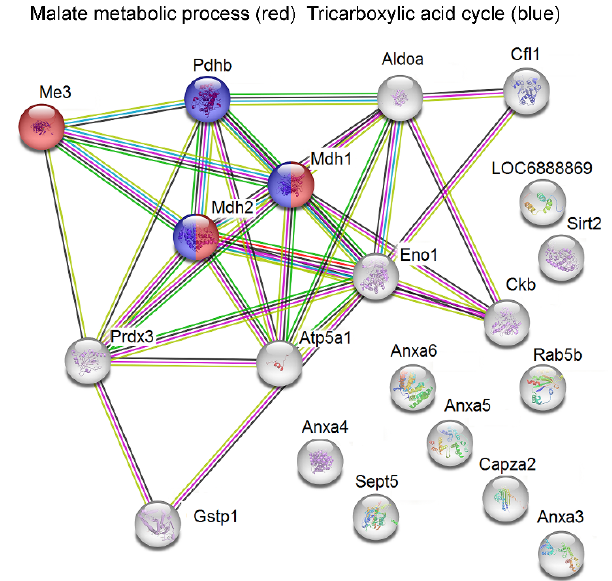
Figure 1. STRING ‐ based detection of modified biological pathways among synaptosomal differentially downregulated proteins following Flx treatment in Control rats; in red, proteins involved in regulation of malate metabolic process; in blue, proteins involved in tricarboxylic acid cycle; Mdh2–malate dehydrogenase, mitochondrial; Mdh1–malate dehydrogenase, cytoplasmic; Me3–malic enzyme; Pdhb–pyruvate dehydrogenase E1 component subunit beta.